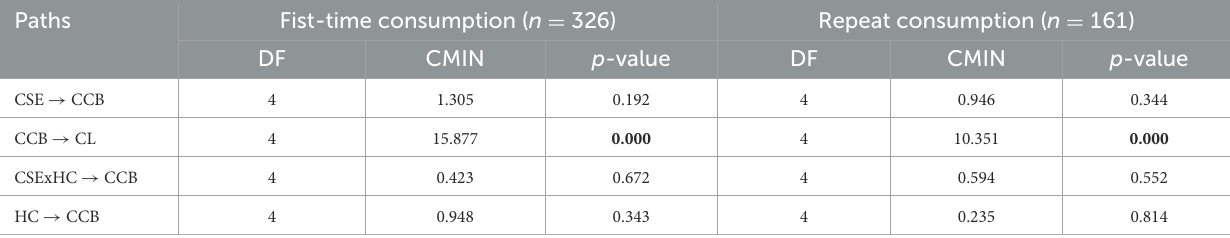
TABLE 4 MGA test results.